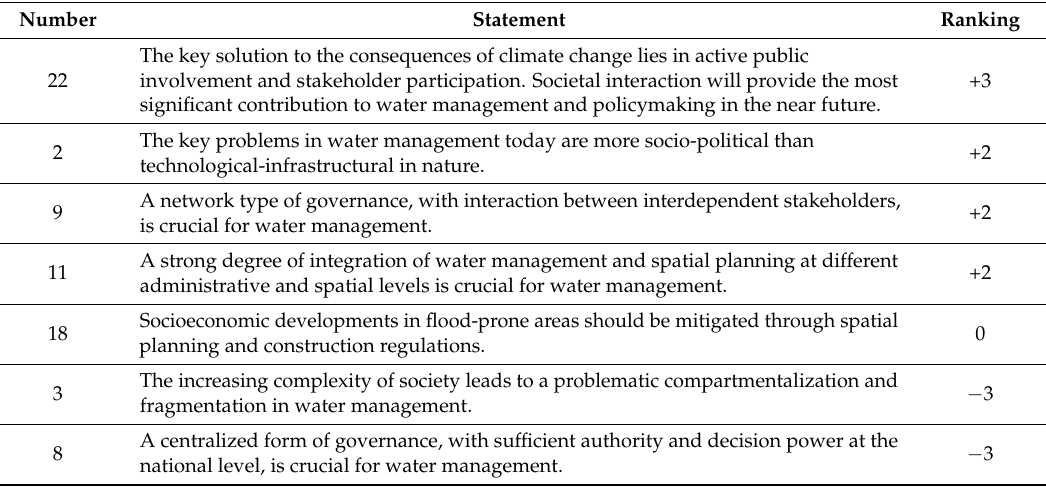
Table 3. Distinguished statements about IWRM in frame NL2.